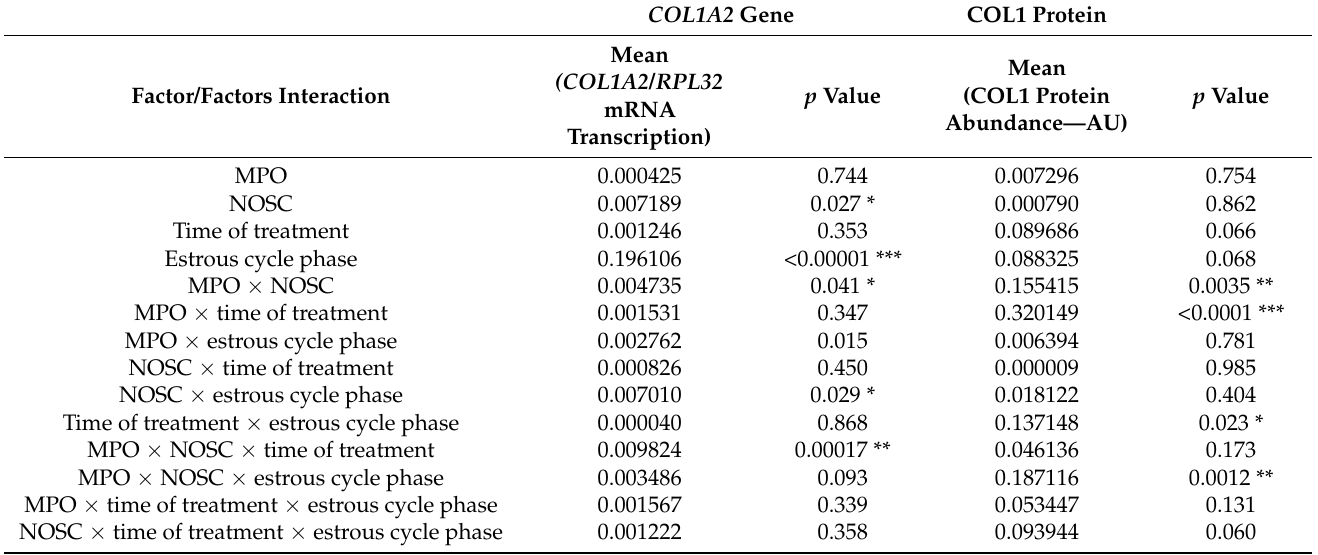
Table 2. Listed means and levels of significance ( p values) in the analyses of relative transcript COL1A2 gene and COL1 protein relative abundance for two- and three-way interactions between the estrous cycle phase, treatment time, and myeloperoxidase (MPO) or noscapine (NOSC) treatments. The results were considered significant at p <